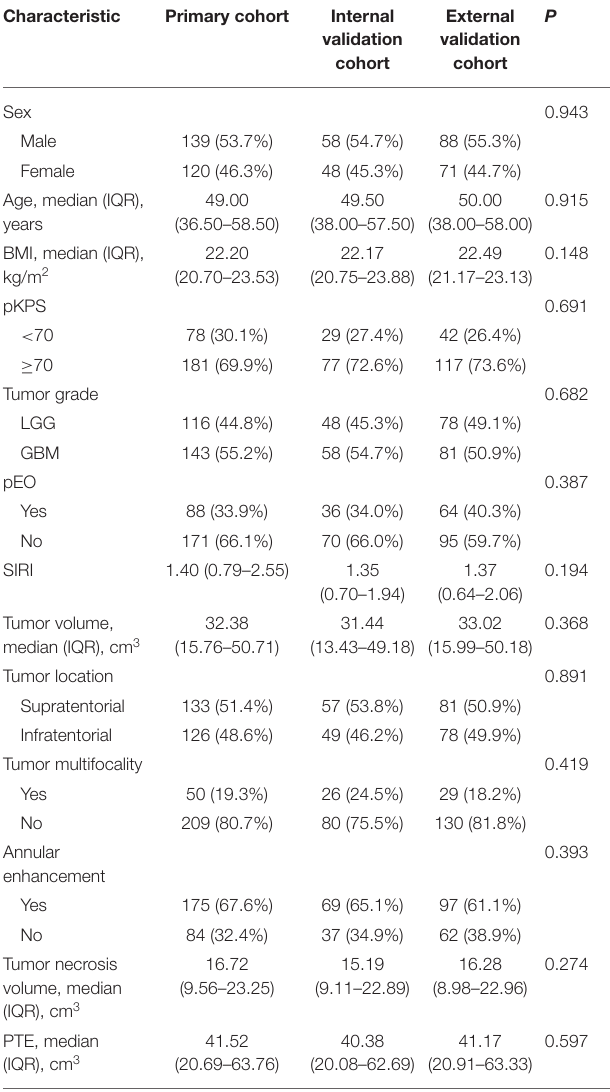
TABLE 1 | Clinical characteristics of patients in the primary and validation cohorts.